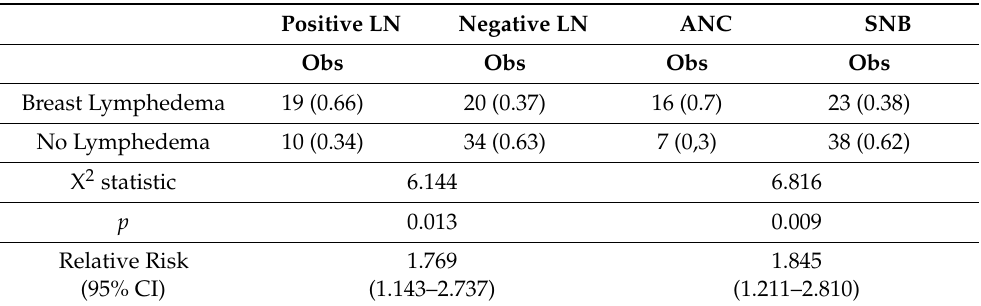
Table 2. Chi-Squared test comparing axillary surgery and the presence of positive lymph nodes. (Obs = observed (proportion).